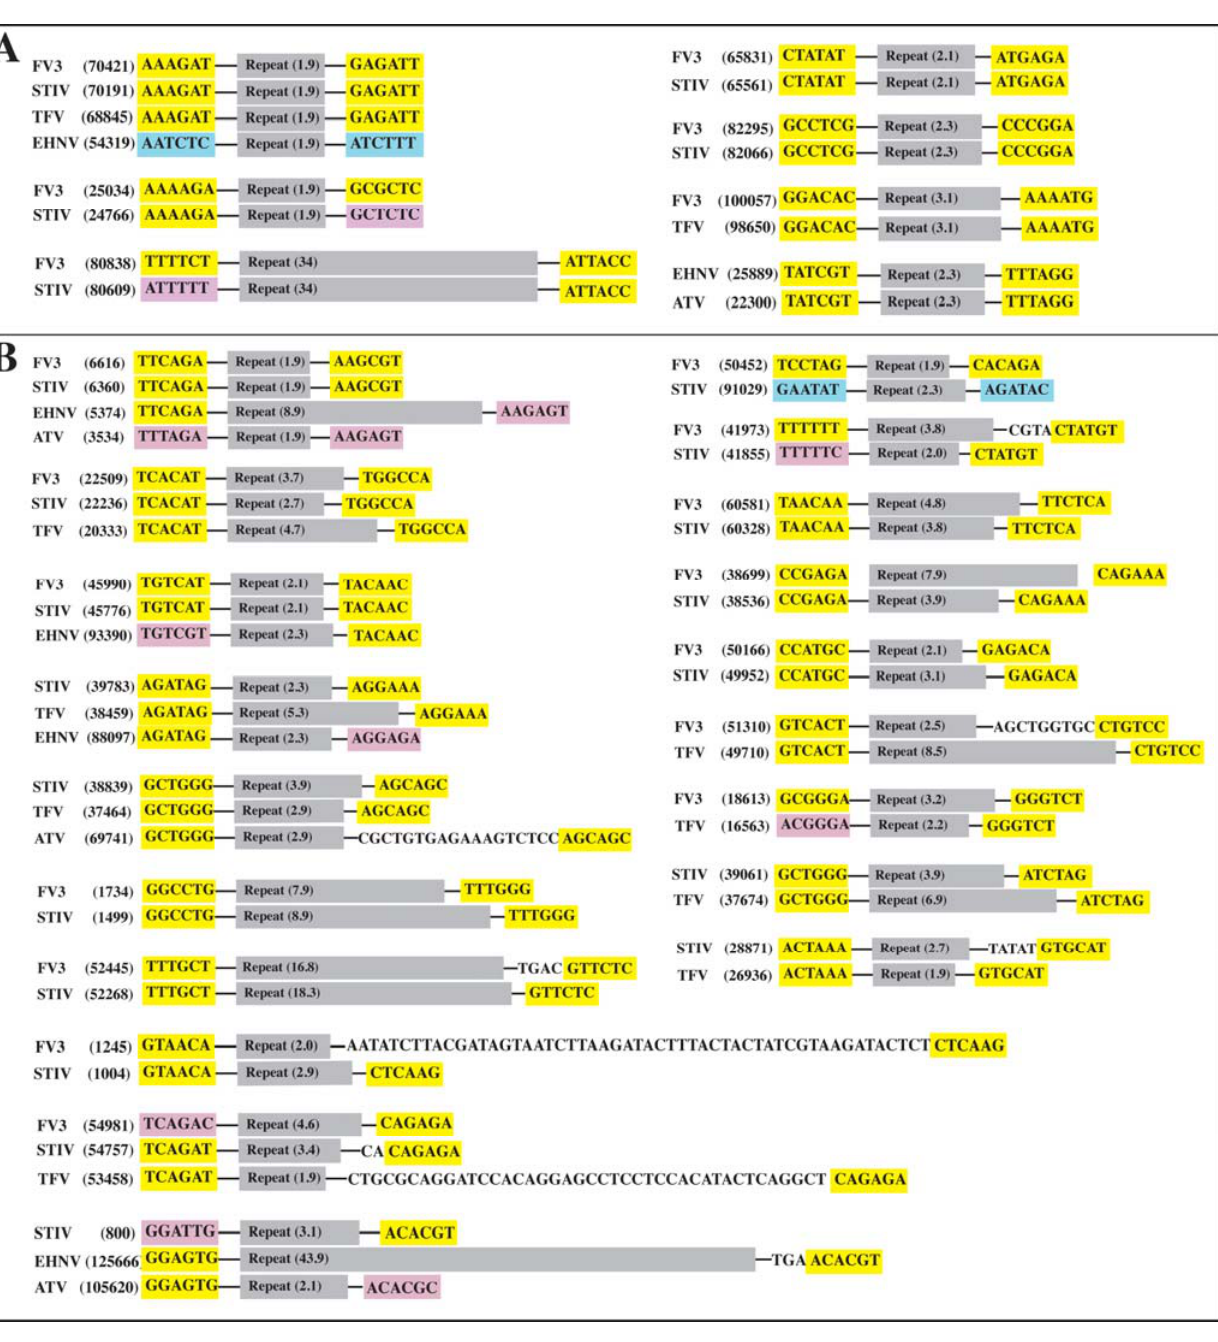
Figure 4. Repeat flanking regions are highly conserved . Regions flanking the repeats common to 2 or more viruses from the first subset of Ranaviruses (FV3, STIV, TFV, EHNV, ATV) are shown. Flanking regions exhibiting perfect conservation are shown in yellow. Flanking regions that show high conservation but with one nucleotide change are shown in pink. Flanking regions demonstrating no conservation are shown in blue. Repeats are displayed in gray and the copy number of each repeat is displayed in black. (A) Repetitive sequences that display identical copy numbers and (B) repetitive sequences that display changes in copy numbers are